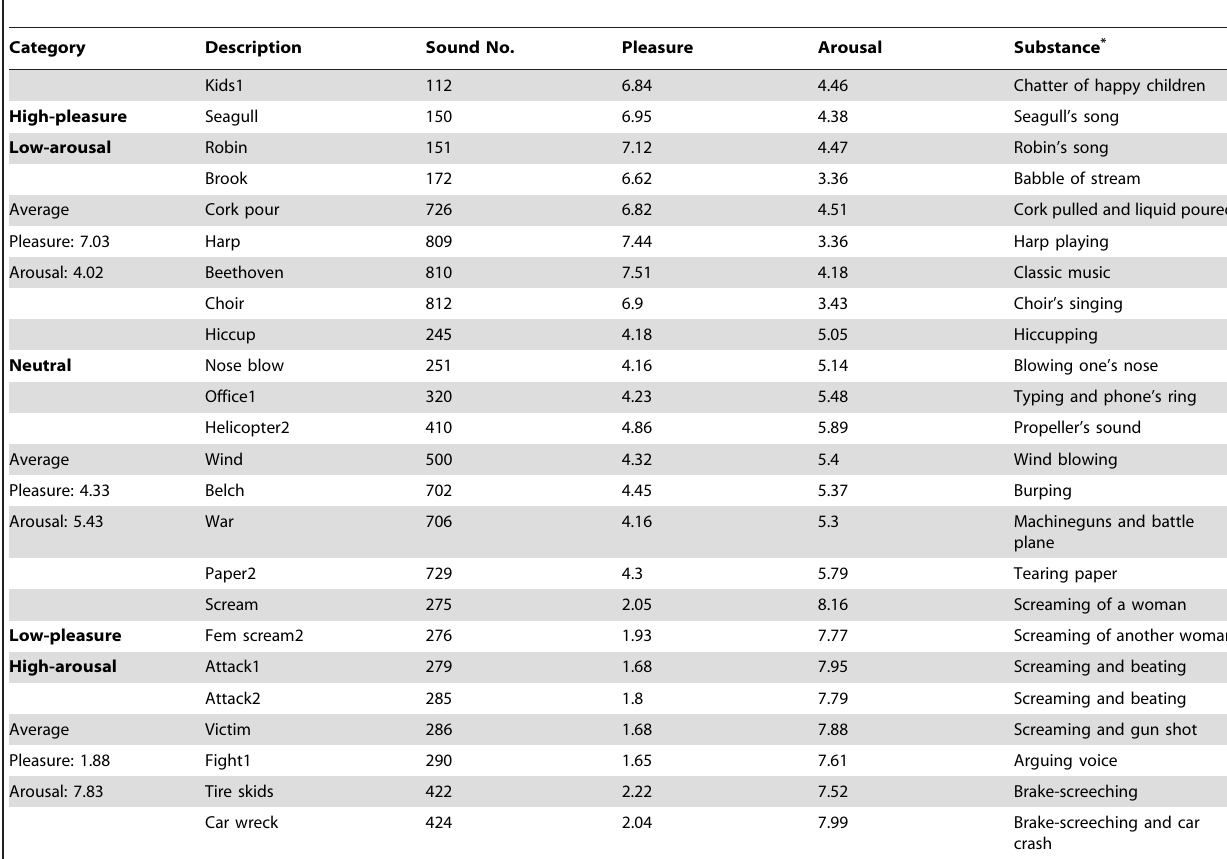
Table 1. Contents and affective ratings of auditory stimuli adopted from IADS-2.